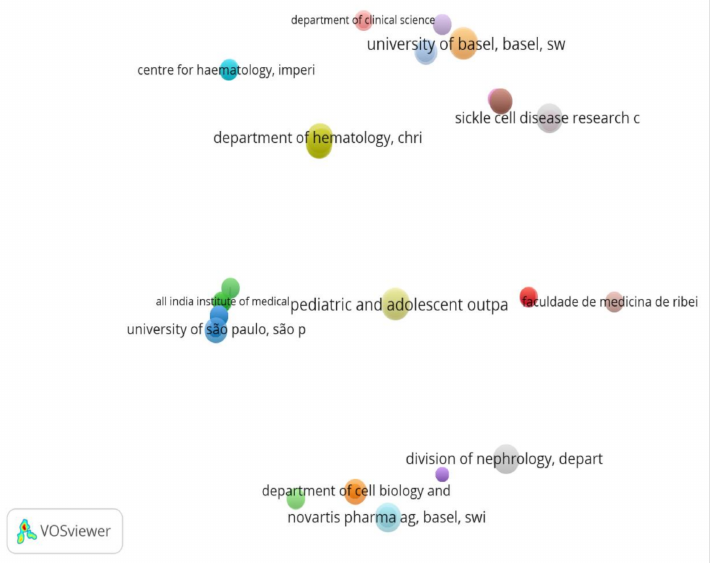
Figure 8. BRICS organizations with at least three published documents within the last three